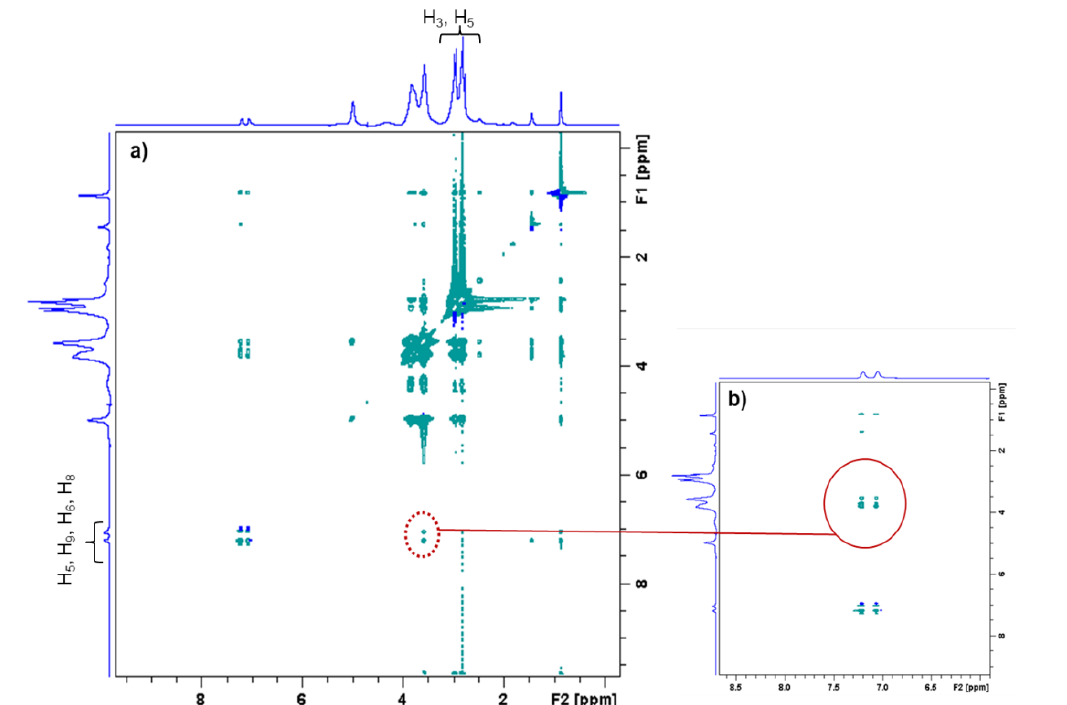
Figure 4. (a) 2D-NOESY NMR spectrum of PCD and IBU. ( b ) Enlargement of 2D-NOESY NMR spectrum. The red circle indicates the correlation mark corresponding the inclusion of IBU into the βCD cavities of PCD.